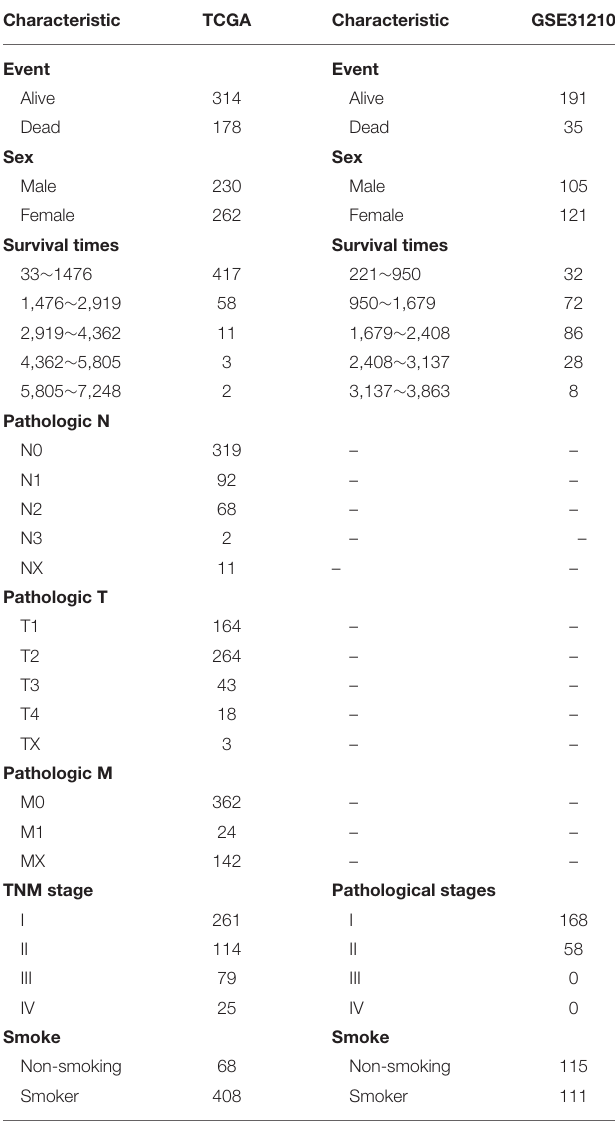
TABLE 1 | Pre-processed clinical information of the two cohorts in LUAD. Characteristic